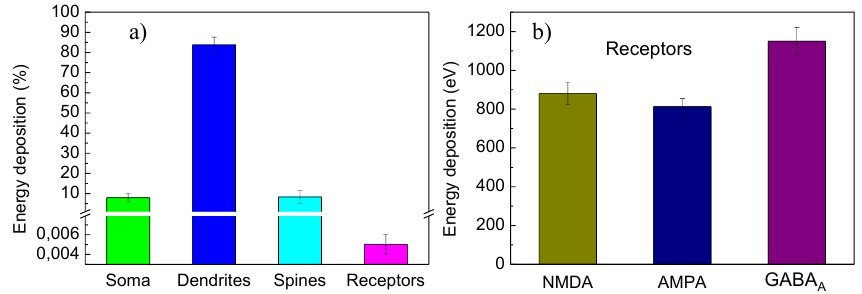
Figure 5. Percentage of energy deposition in di ff erent components (Soma, Dendrites, Spines and Receptors) of CA1 pyramidal neuron after irradiation (a). Energy deposition in di ff erent types